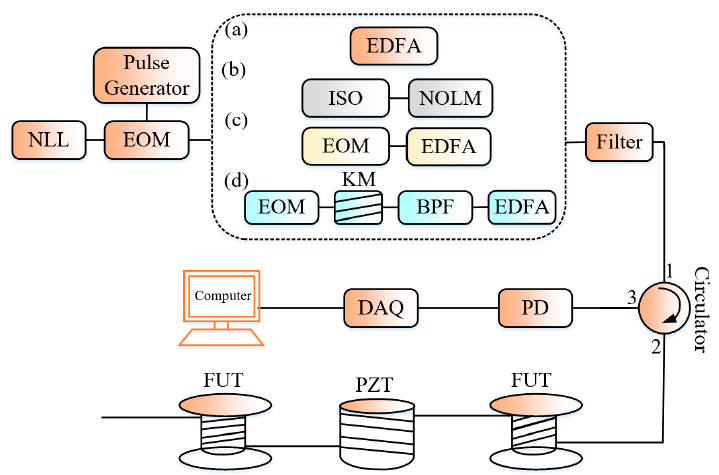
Figure 3. Experimental setup for comparison of the Φ -OTDR system basing on the ER : ( a ) conventional scheme; and higher ER schemes with: ( b ) NOLM: non-linear optical loop mirror ( c ) two-cascaded EOMs and ( d ) the nonlinear Kerr effect respectively. ISO: optical isolator, KM: Kerr medium, the other acronyms are defined previously.